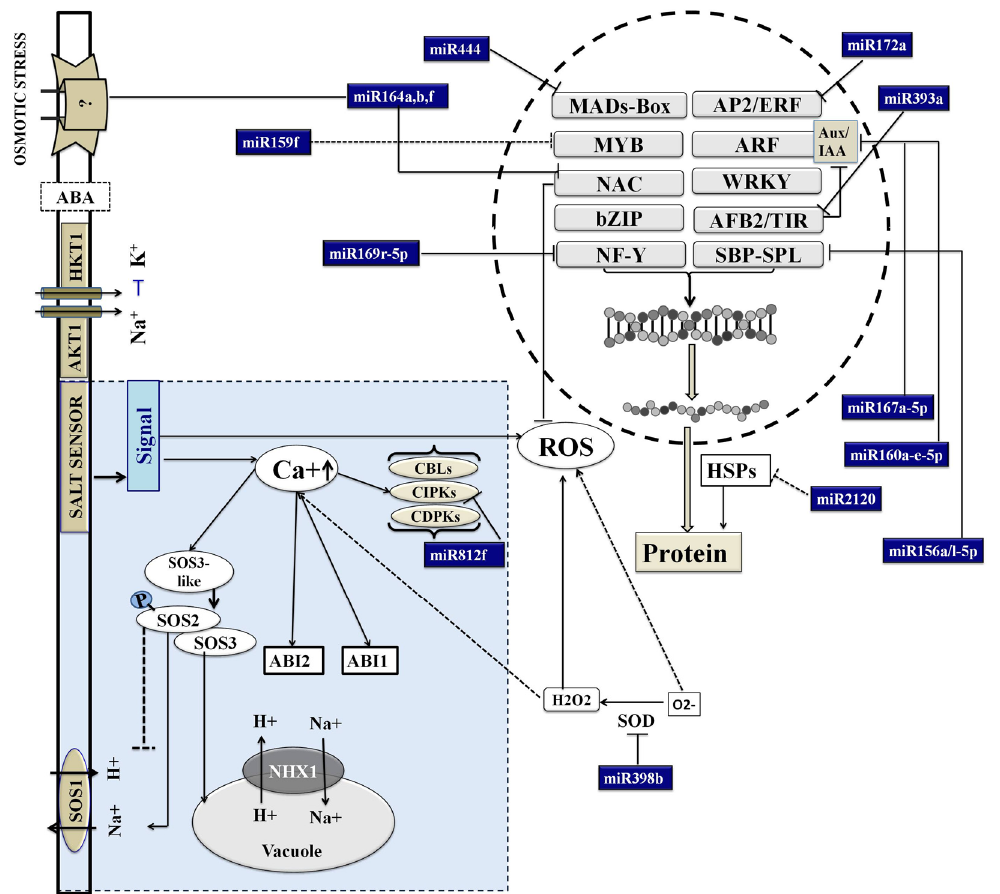
Figure 7. A hypothetical model built on the key Pokkali miRs and their predicted targets to represent the regulatory transcription factors. The maintenance of calcium and ROS homeostasis by miRs is also shown. These components act upstream to control the metabolic network that plays an important role in enabling plants to adapt to saline environments.